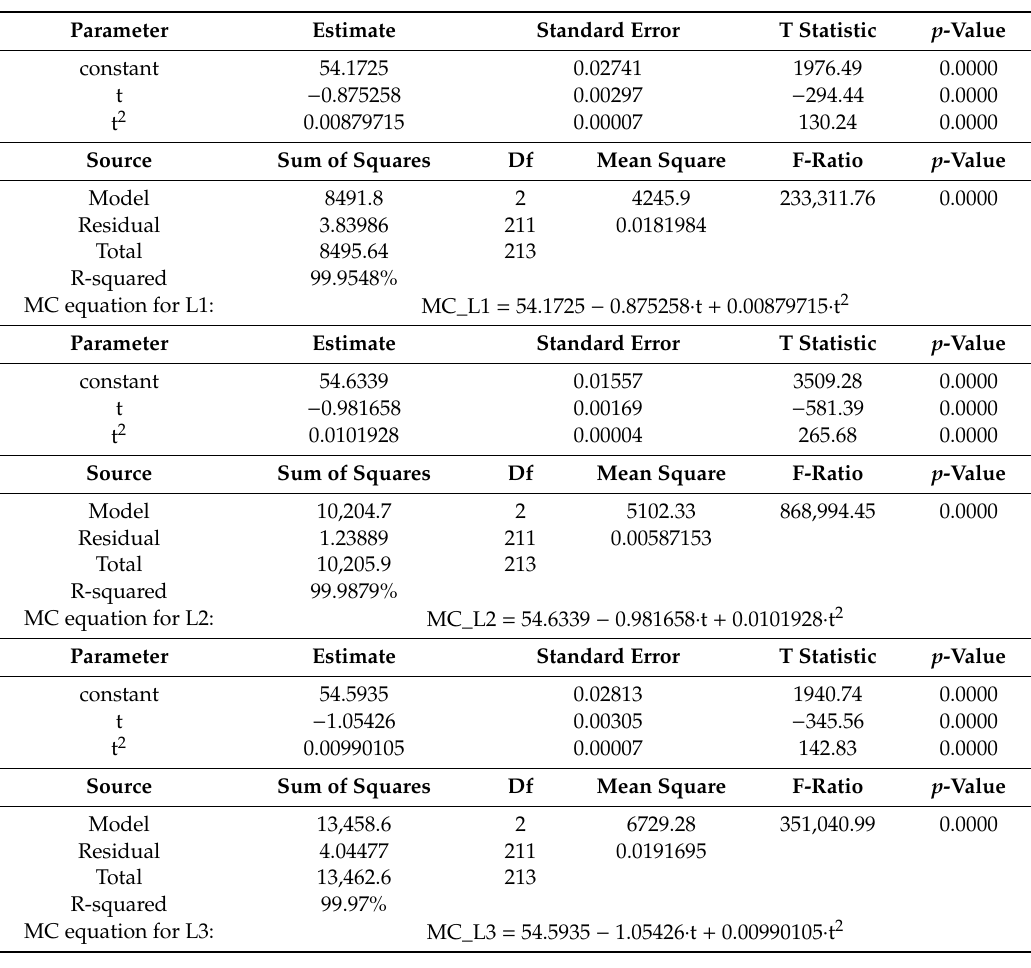
Table 5. Polynomial regression analysis results for drying rate DR as a function of time for